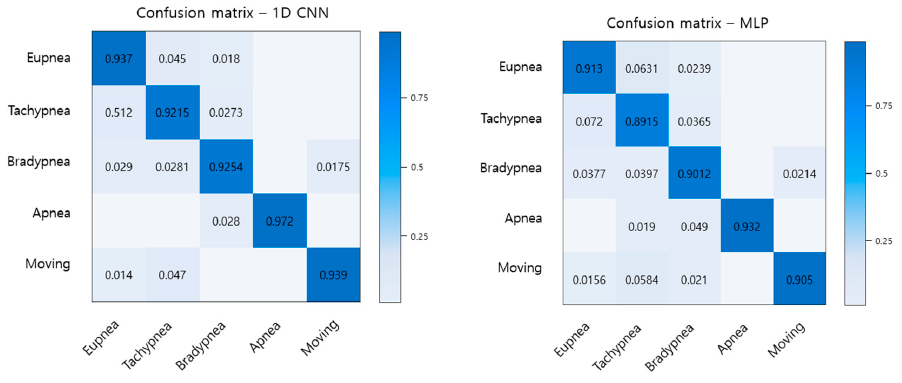
Figure 15. The results of performance obtained by using the optimal parameters of the proposed 1 D CNN model.